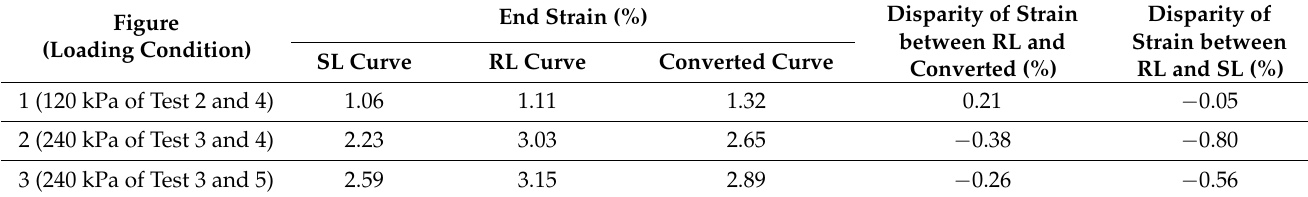
Table 3. End strain of SL, RL, converted strain–time curve of three loading conditions. End Strain (%) Disparity of Strain